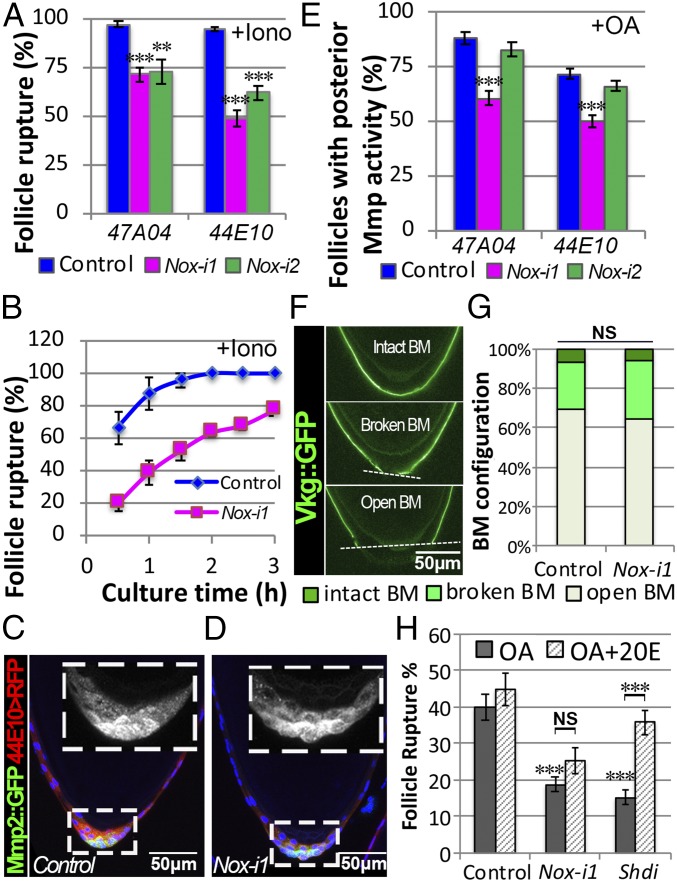
NOX does not interfere with the OA/OAMB-Ca2+–MMP2 pathway. (A) Quantification of follicle rupture after 3-h culture with 5 μM ionomycin. The numbers of follicles used in each genotype are 199, 134, 111, 446, 357, and 268. (B) Cumulative follicle rupture in 3 h in response to ionomycin stimulation. Mature follicles were isolated according to 47A04-Gal4 and three groups of each genotype (∼90 follicles) were used. (C and D) Representative images show MMP2::GFP expression (green in C and D and white in Insets) in mature follicles of control (C) and Nox-i1 (D) driven by 44E10-Gal4. The mature follicle cells are marked by 44E10-Gal4 driving UAS-RFP (44E10>RFP; red in C and D). Only the posterior portions of the follicles are shown. DAPI (blue in C and D) is used to mark nuclei. (E) Quantification of posterior MMP activity in control and Nox-i mature follicles with 47A04-Gal4 or 44E10-Gal4 after 3-h culture with OA using in situ zymography. The numbers of mature follicles used in each genotype are 556, 539, 322, 478, 466, and 259. (F) Representative images show three categories of BM configurations (according to Vkg::GFP expression in green) in isolated mature follicles. (G) Quantification of BM configuration of isolated mature follicles from control or Nox-i1 females with 44E10-Gal4. (H) Quantification of follicle rupture after treatment with or without 20 nM 20E for 30 min followed by a 6-h OA culture. The numbers of mature follicles used in each genotype are 327, 355, 324, 367, 169, and 226. **P < 0.01, ***P < 0.001. BM, basement membrane; Iono, ionomycin; Nox-i, Nox-RNAi.